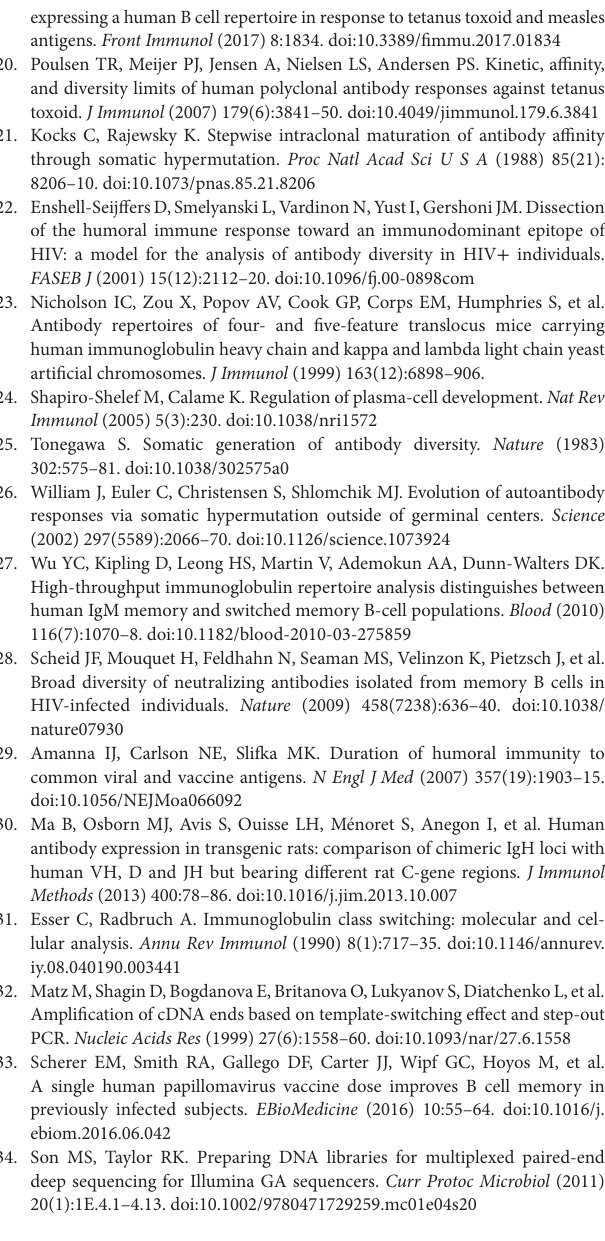
pass the quality control filters described in the methods. Column 4 shows the percent of the QC forward and reverse read pairs that were successfully merged. Column 5 shows the total number of productive VH open reading frames identified in the merged reads that were used in downstream